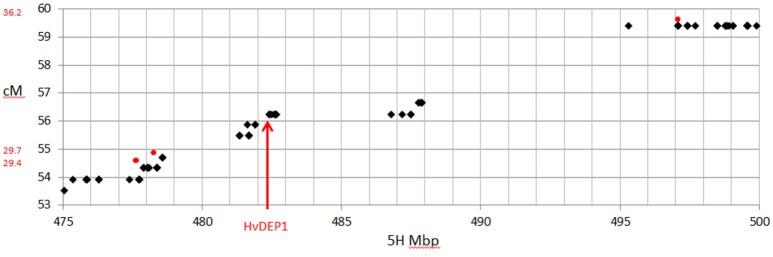
Comparison of genetic map and physical position on chromosome 5H around the position of HvDEP1, the causal gene underlying the ari-e.GP mutant phenotype mapped in the GP × Mo RIL population. SNPs from the 50k are shown as black diamonds and the three GBS SNPs are shown as red circles.